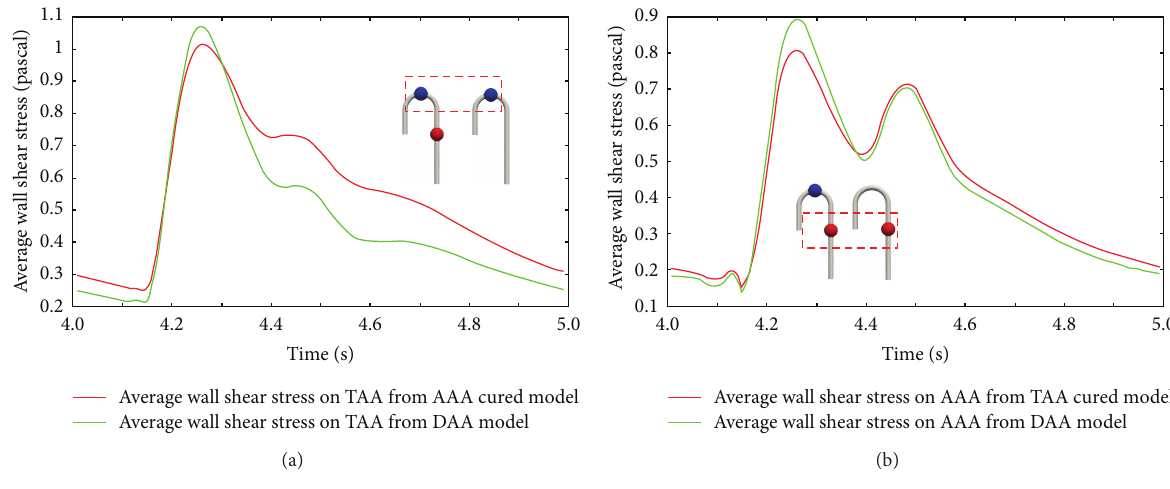
Figure 9: Average wall shear stress per cycle: (a) average wall shear stress comparison in TAA, (b) average wall shear stress comparison in AAA green line. Presurgery double aneurysms, red line: post surgery TAA cured or AAA cured.